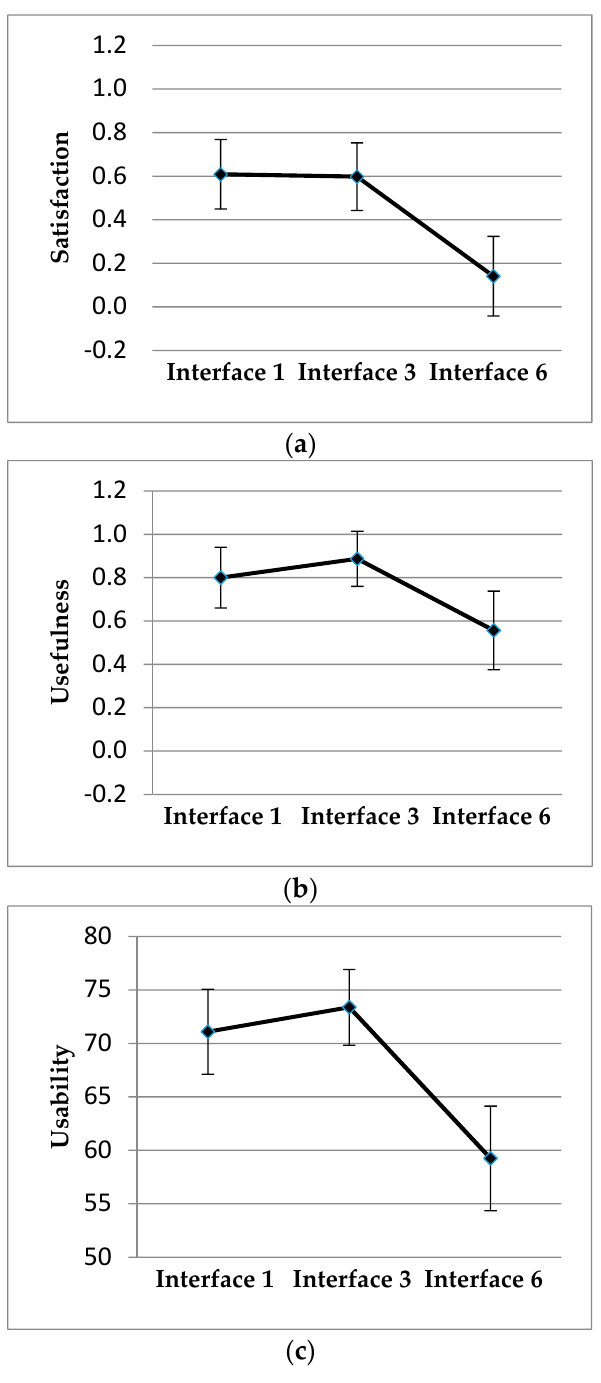
Figure 4. Mean and standard error of ( a ) Satisfaction; ( b ) Usefulness; ( c ) Usability.